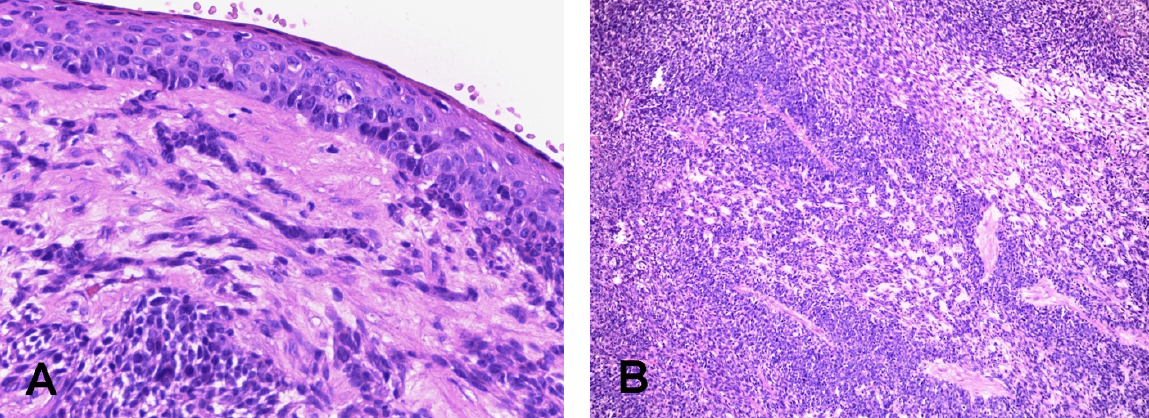
Figure 1. HPV related multiphenotypic carcinoma. The surface epithelium shows severe atypia (( A ) Hematoxylin and eosin, 20× Objective original magnification)). In this example, tumor cells presented a solid growth pattern with large lobules composed of spindle cells organized in fascicles intermixed with areas resembling non-keratinizing squamous cell carcinoma ( B ). Prominent dilated “hemangiopericytoma-like” vessels are present in the background (Hematoxylin and eosin, 10× Objective original magnification).